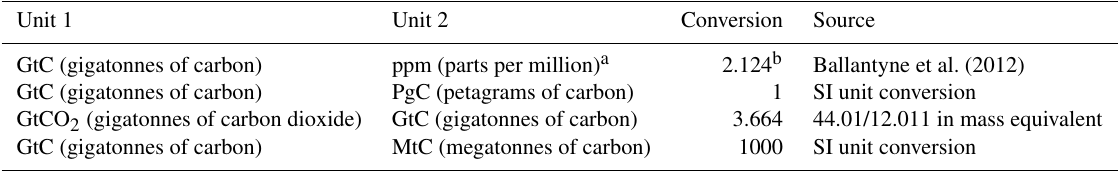
Table 1. Factors used to convert carbon in various units (by convention, unit 1 = unit 2 ×